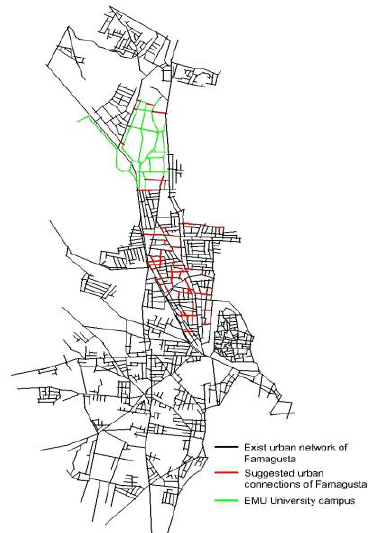
Figure 2. Axial map of the existing pattern and the suggested